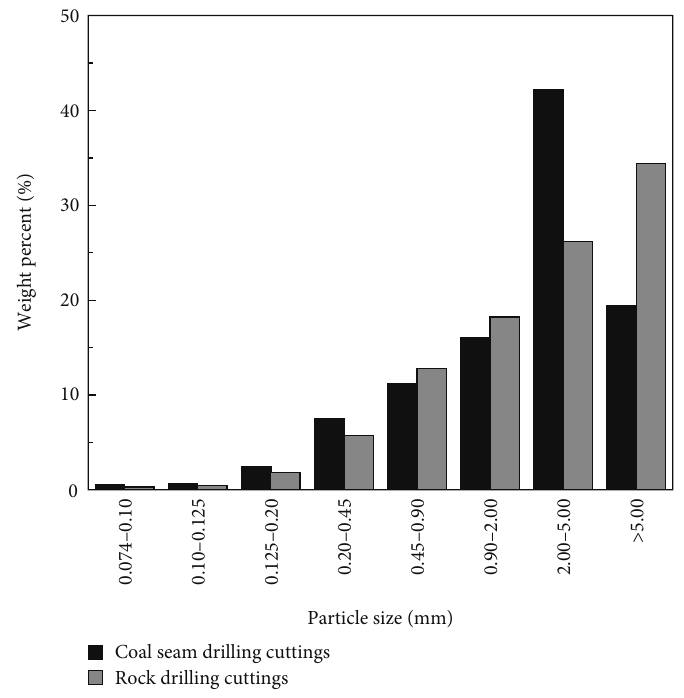
Figure 4: Particle size distribution of drilling debris for both rock layer and coal